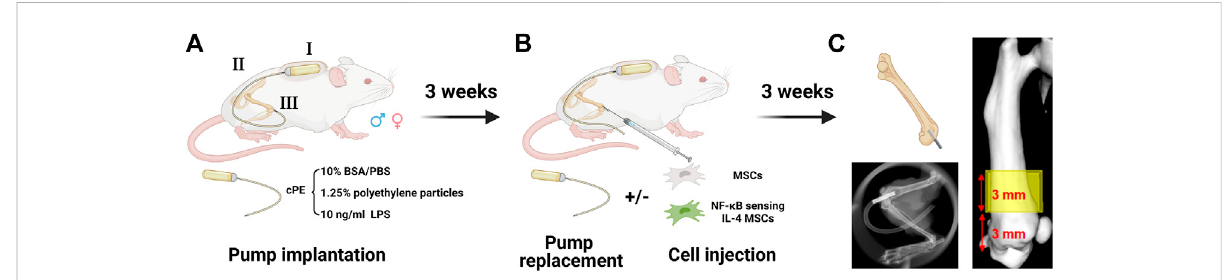
FIGURE 1 Mouse model and experimentaldesign of chronic in fl ammation and bone resorption due to contaminatedpolyethylene particles (created with Biorender.com). (A) the murine continuous femoral particle infusion model. I: cPE were continuously infused from a dorsally implanted pump; II: vinyl catheter connecting tube; III: 6-mm titanium hollow rod placed into the distal femur. (B) mesenchymal stromal cell (MSC) or NF κ B-IL4 MSC injection and pump replacement at the second surgery at 3 weeks (C) femurs were harvested at 6 weeks for further analysis. The region